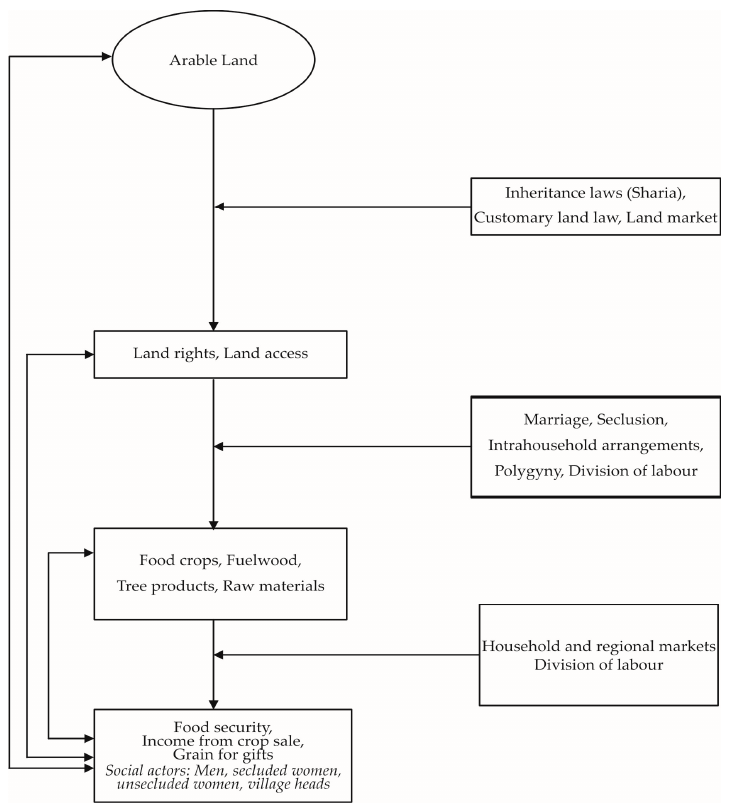
Figure 2. Environmental entitlements mapping: land (adapted from leach et al. [33]).